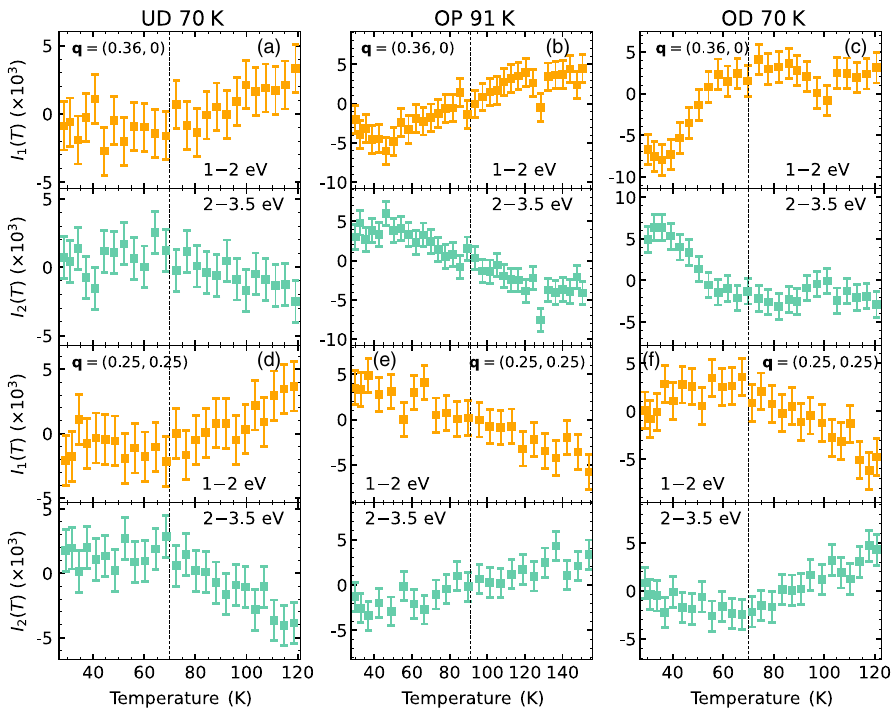
ð T Þ where the index j ¼ 1 , 2 refers to the two energy ranges 1 – 2 j . Top panels: momentum value (0.36, 0). Bottom panels: momentum c ¼ 70 K). (b),(e) Optimally doped Bi-2212 ( T c